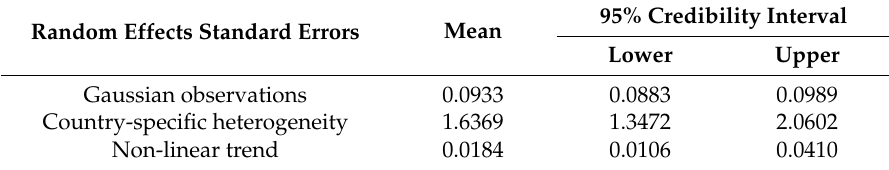
Table 4. Results of the estimation of the models with dependent variable, CO 2 total base 1990.